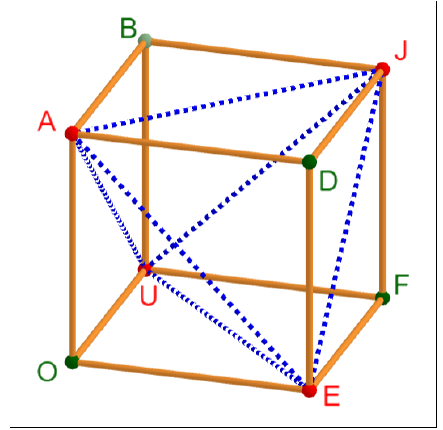
Figure 9. Adding bars to the cube to make it